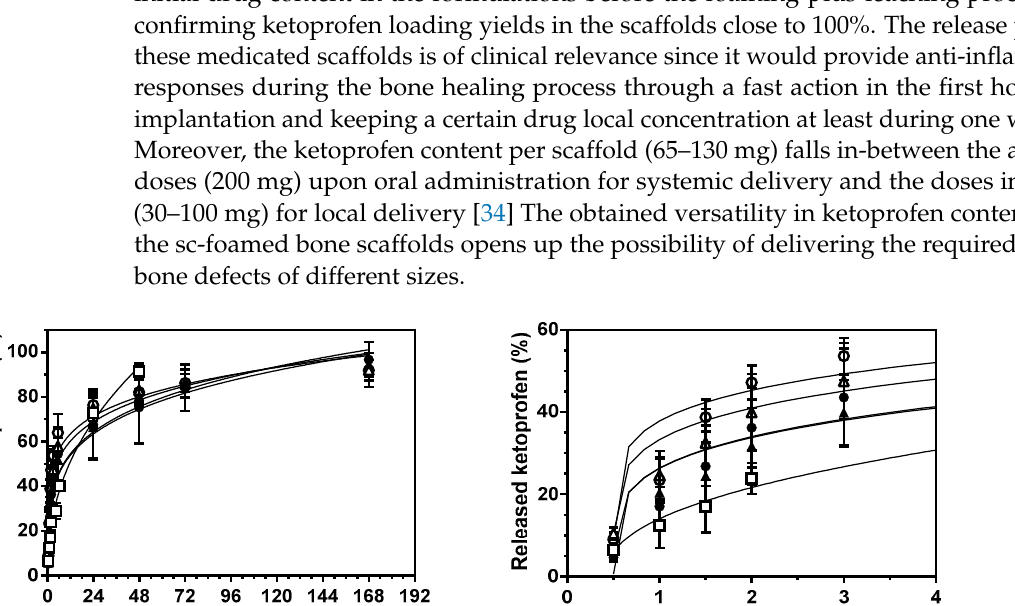
Table 2. Kinetic fitting parameters to the Korsmeyer-Peppas with lag time drug release model (Equation (2)) of ketoprofen released from PCL-scaffolds obtained by sc-foaming in PBS pH 7.4 medium at 37 °C and 60 rpm.